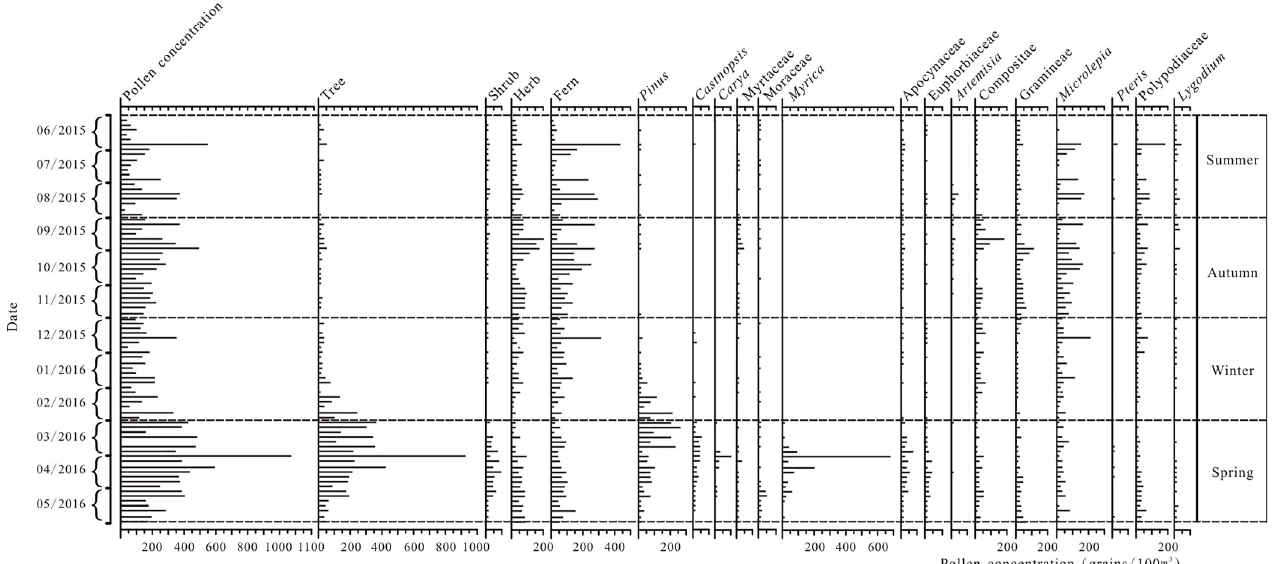
Fig 3. Concentrations of airborne pollen in different months in central Zhanjiang city during 2015~2016.